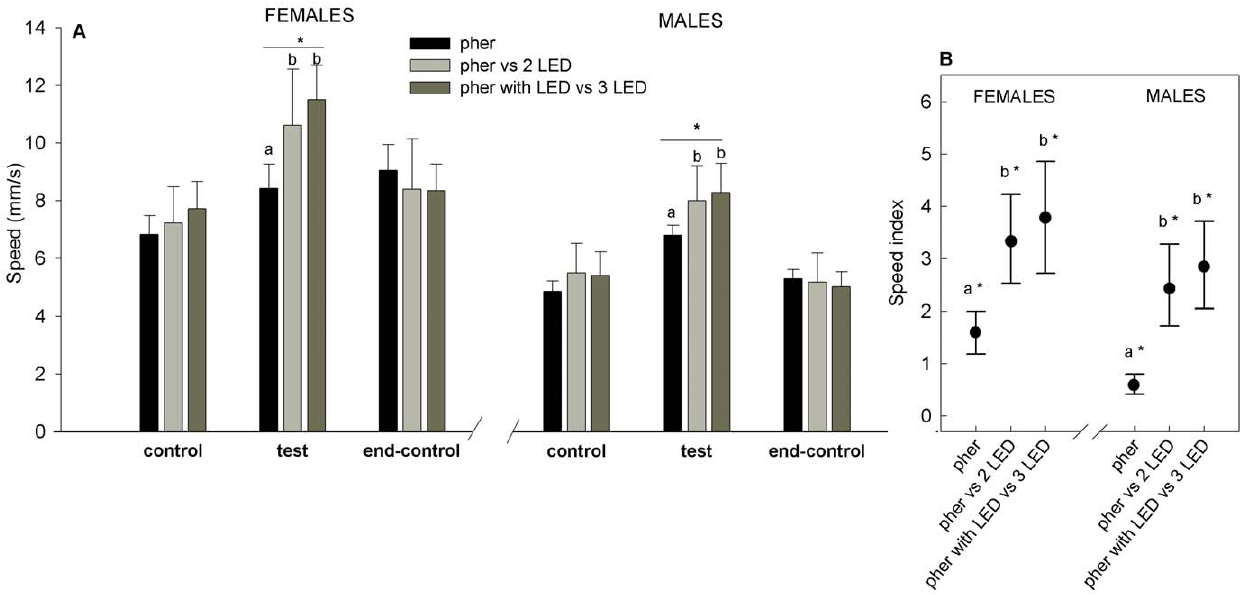
Figure 6. Walking speed of Colorado potato beetle is increased by light and pheromone. Speed reached by CPBs during stimulation with: the pheromone alone (pher), the pheromone versus two LED beams of yellow light perpendicular to the air stream (pher vs. 2 LED) and the pheromone plus one LED versus three opposite LED beams of yellow light: two perpendicular and two parallel to the air stream (pher with LED vs. 3 LED). a. Average speed during the three experimental periods (control, test and end-control) of females and males. Asterisks (*) over the horizontal lines indicate that velocities were significantly different between the three stimulation treatments (one-way ANOVA, p , 0.01). b. Speed index was calculated as the average speed during the test period minus the average speed during the first control period. Asterisks (*) indicate means that are significantly different from zero (Paired t-test, p , 0.05). Different letters indicate significant pairwise differences across the different directions (Tukey- Kramer’s post-hoc tests, p , 0.05). The black filled circles mark the mean and bars below and above indicate the standard error.